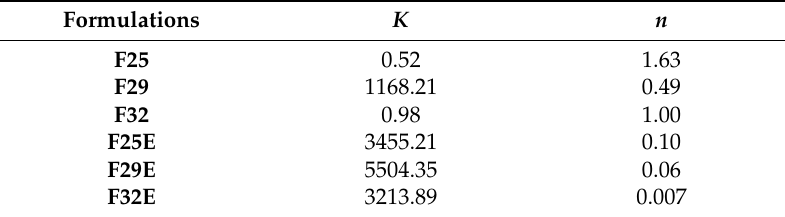
Table 2. Consistency index ( K ) and flow behavior index ( n ) for all